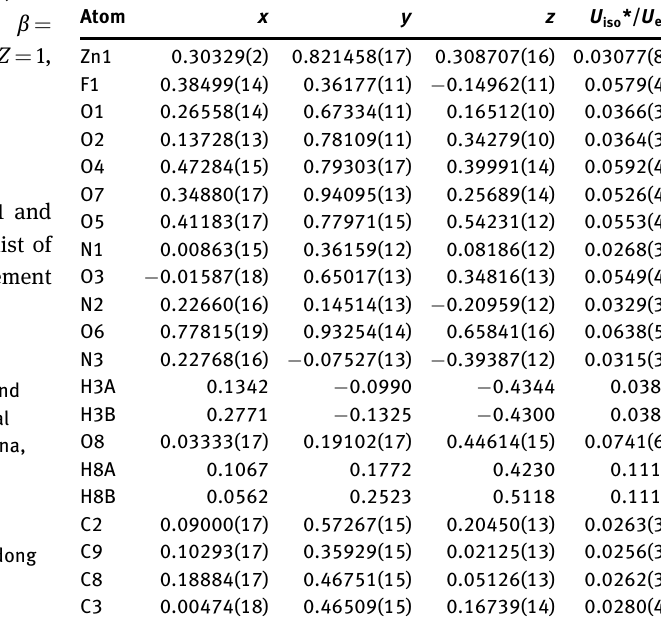
Table 2: Fractional atomic coordinates and isotropic or equivalent isotropic displacement parameters (Å 2